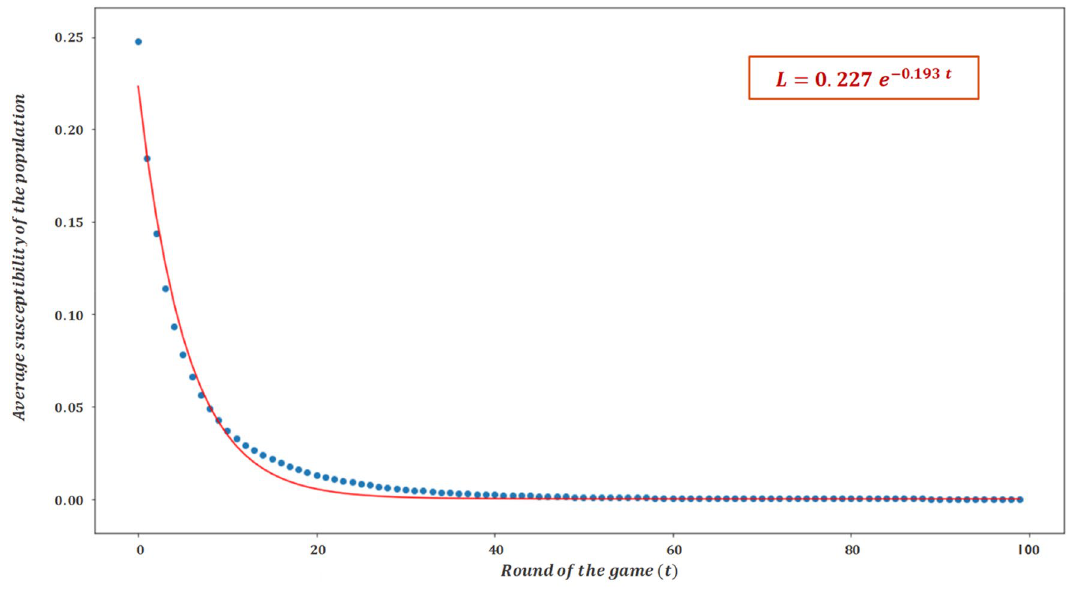
Figure 7. Evolution of agents’ average susceptibility for W emp , neg = W nor , neg = 1 , W emp , pos = W nor , pos = 1 3 emp and l nor i , t = l i , t